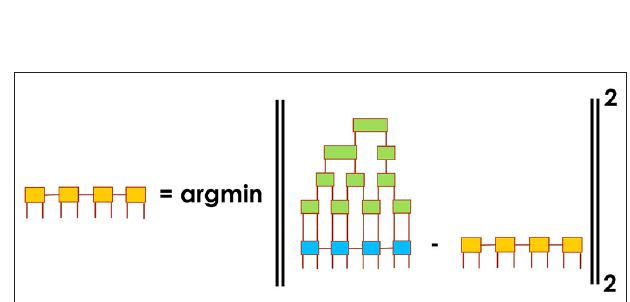
FIGURE 7 | An example of reconstruction of one (more complex) tensor network as another (simpler) tensor network by minimizing the Euclidean norm of the